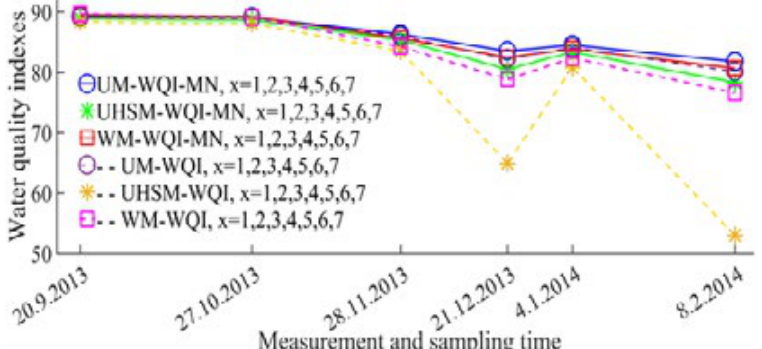
Fig. 4: Change of water quality indices with seven parameters with respe ct to time for station BM Fig. 5: Change of water quality indices with seven parameters with respect to time for station BM